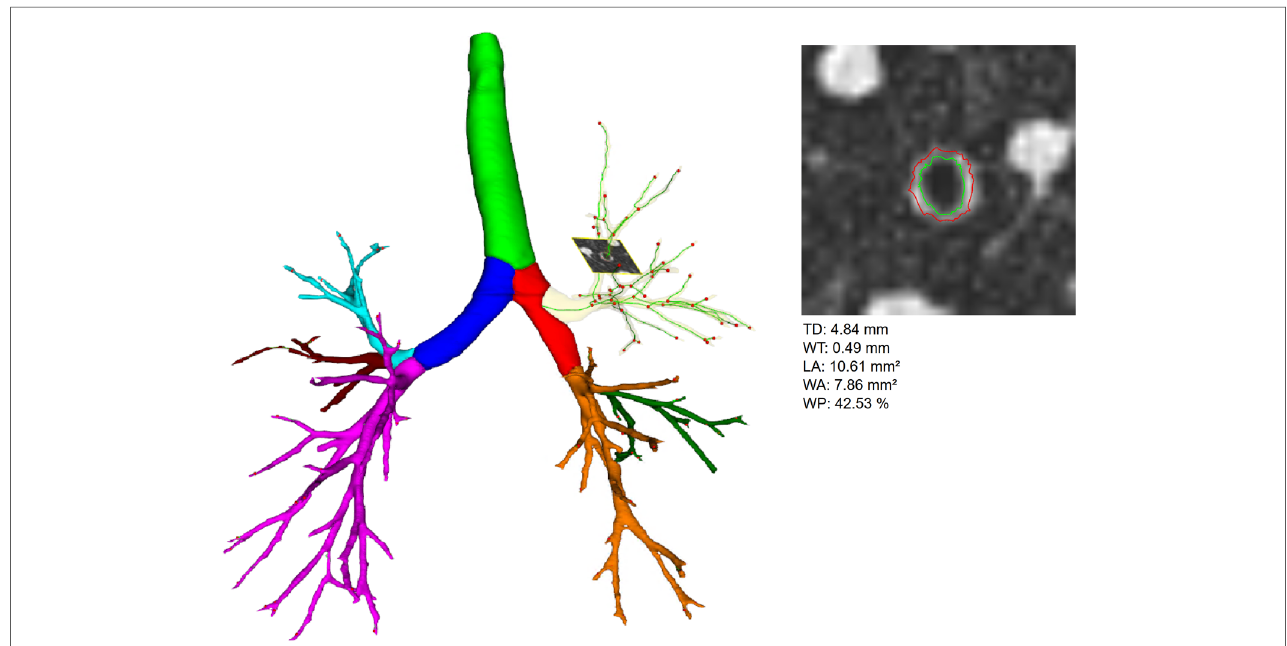
FIGURE 1 Left side shows a segmented airway tree including labeling of the pulmonary lobes, trachea highlighted in green, right main in red, left main in dark blue, right upper lobe in yellow (transparent), middle lobe in green and right lower lobe in orange, left upper lobe in light blue, lingula in dark red, and left lower lobe in pink. In the right upper lobe an orthogonal slice through an generation 6 airway is shown, on such slices, all airways of the whole segmented airway tree are measured. Right side shows the magni fi cation of the orthogonal slice shown on the left side, inner (green) and outer (red) wall borders are displayed. Calculated airway parameters are given below. LA refers to the area within the green inner wall border. WA refers to the area between the green inner and red outer wall border. The other parameters are calculated from these